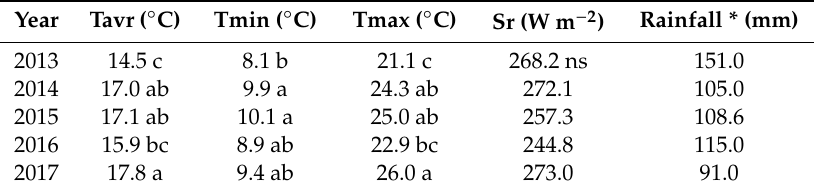
Table 3. Average daily temperature (Tavr), average minimum daily temperature (Tmin), average maximum daily temperature (Tmax) and solar radiation (Sr) and cumulative rainfall (mm) during the fruit growing season (from full blooming until harvest) from 2013 to 2017. Year Tavr ( ◦ C) Tmin ( ◦ C) Tmax ( ◦ C) Sr (W m − 2 ) Rainfall *